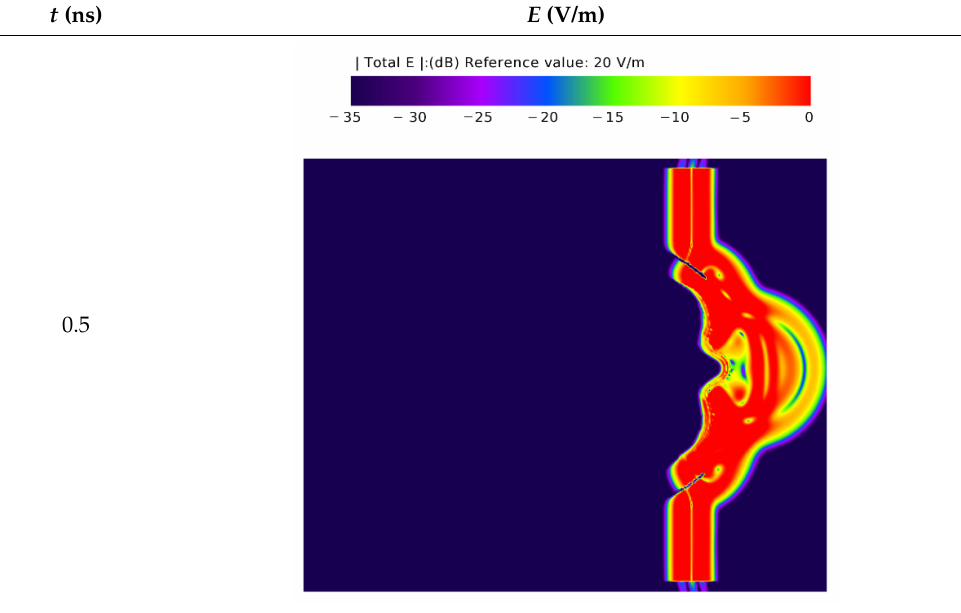
Figure 20. Time domain parameters of the pulse. Table 4. Electric field intensity for subsequent time steps in a pulse-excited model of a solid metal